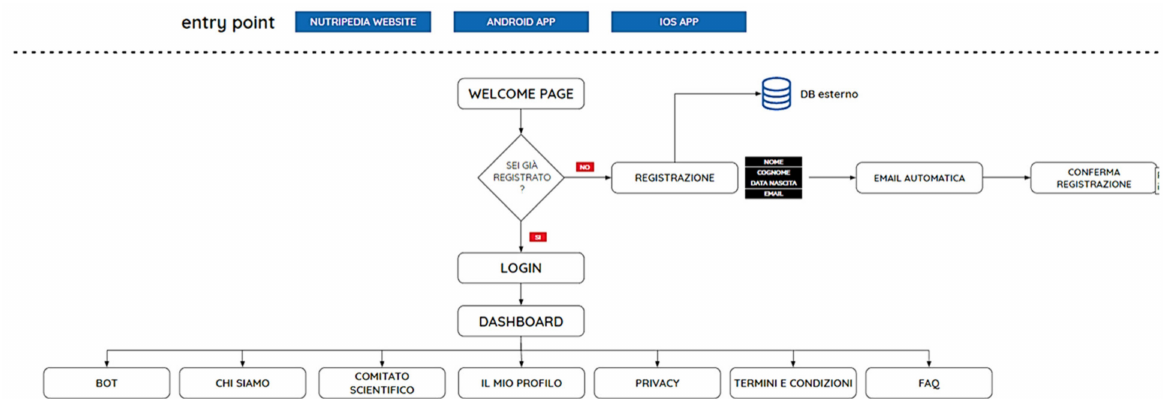
Figure 5. Navigation flow of the Nutripedia-Chatbot app. First impression in the welcome page is “Are you already registered?”: if NO people are asked to REGISTER with their EMAIL, if YES people are asked to LOGIN. After having logged a DASHBOARD appears with different sections: “BOT”, “About us”, “Scientific Committee”, “My profile”, “Privacy”, “Terms and Conditions” and